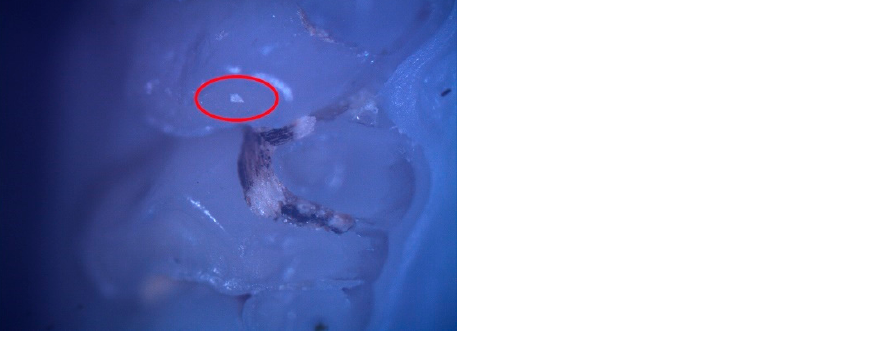
Figure 2. Hypomineralization lesion (surrounded by the red oval) on the occlusal surface of 26.